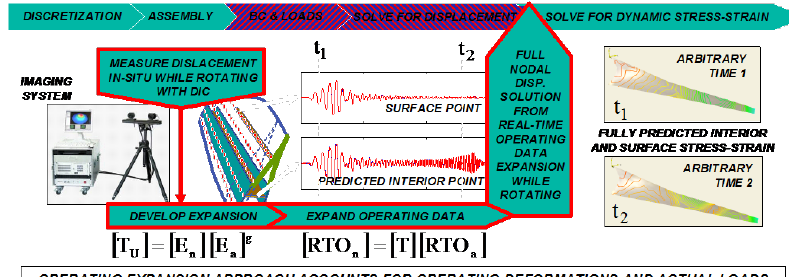
Fig. 2. Schematic showing alternation expansion/solution